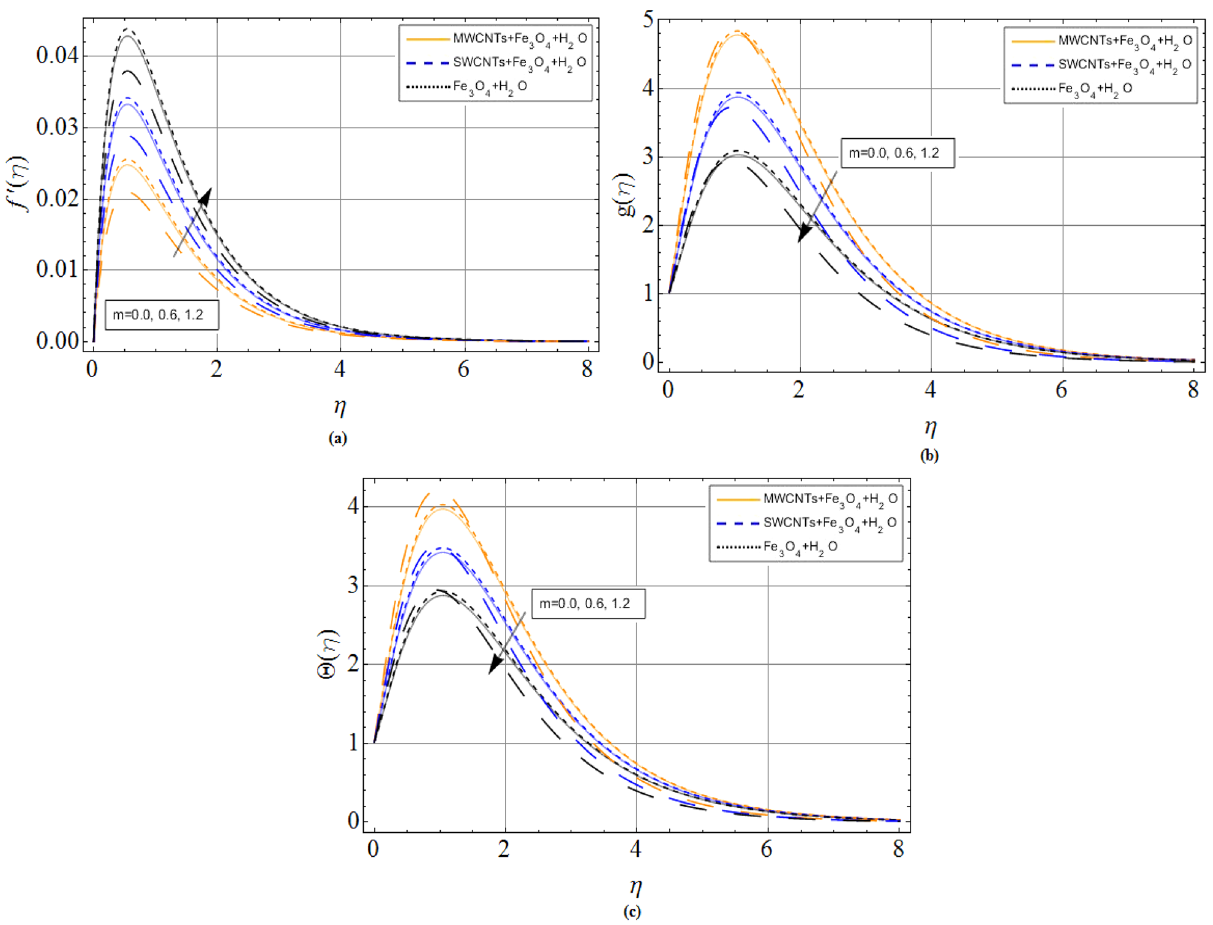
Figure 2. Hall current parameter m effect on ( a ) axial velocity f ′ (η) ( b ) radial velocity g (η) ( c ) temperature �(η) . When φ 1 = 0.01, φ 2 = 0.2, Sc = 2.0, Pr = 6.2, M = 1.0. N =